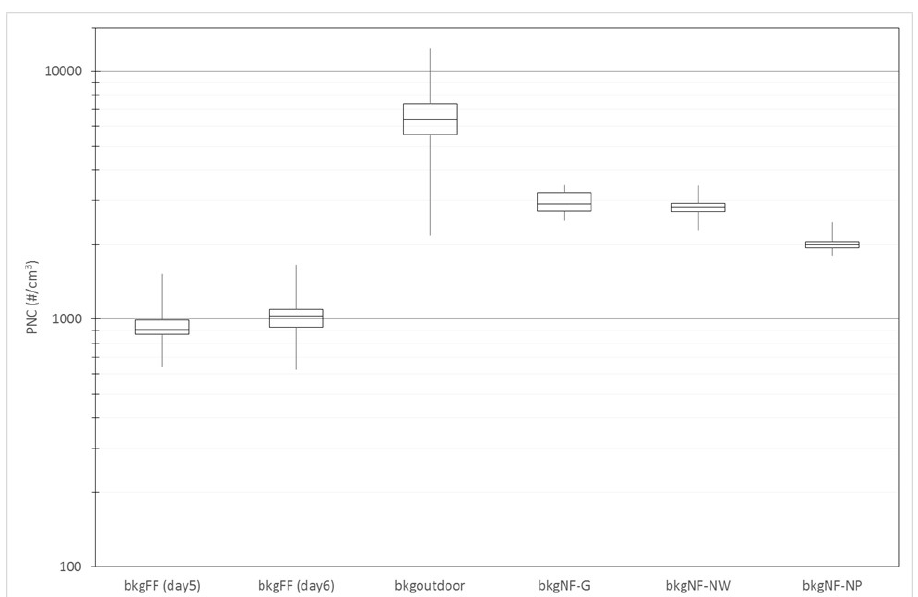
Figure 3. Box plots of far-field (FF), outdoor, and near-field (NF) background particle number concentration (PNC) measured by condensation particle counter (CPC) (#/cm 3 ). Box plots of FF background show an asymmetric distribution of PNC: -